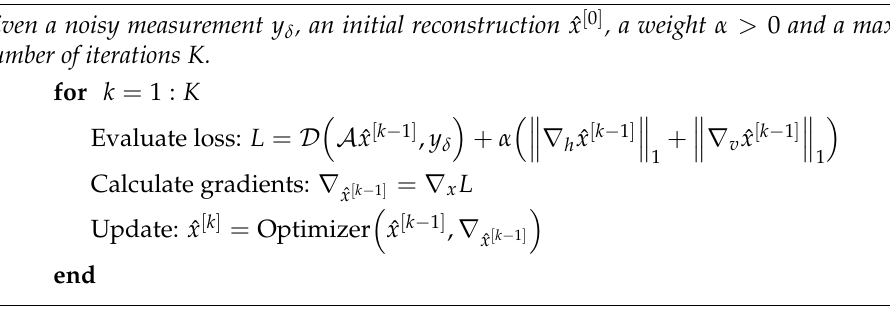
Algorithm A6 Total Variation Regularization